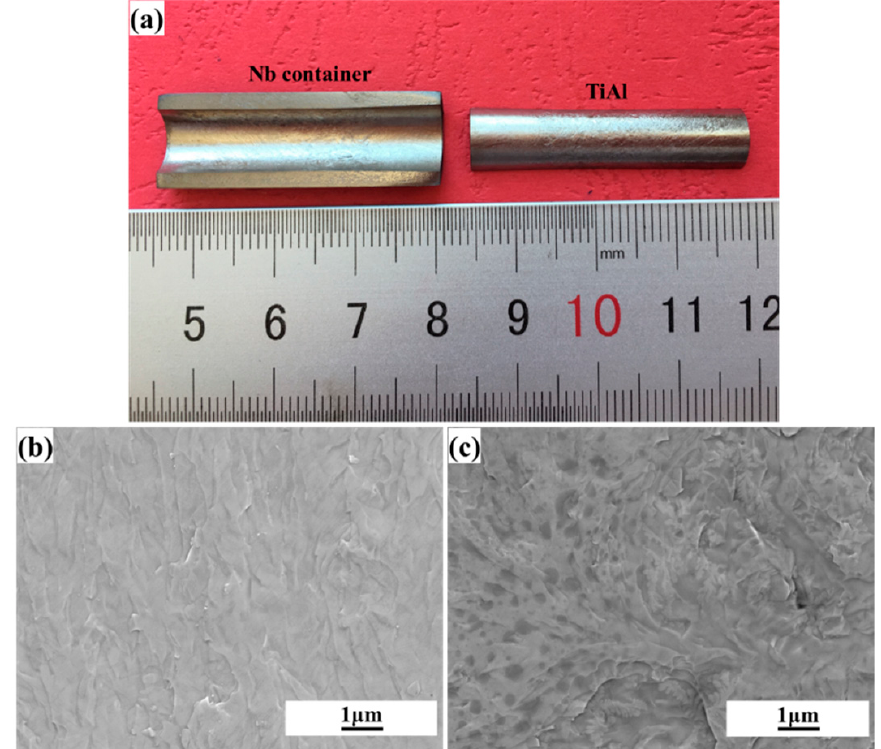
Figure 3. Fracture morphology of the sample: ( a ) Macro fracture picture of the interface, ( b ) SEM-SE micrograph of crack surface inside the Nb container, ( c ) SEM-SE micrograph of crack on the surface of TiAl sample.